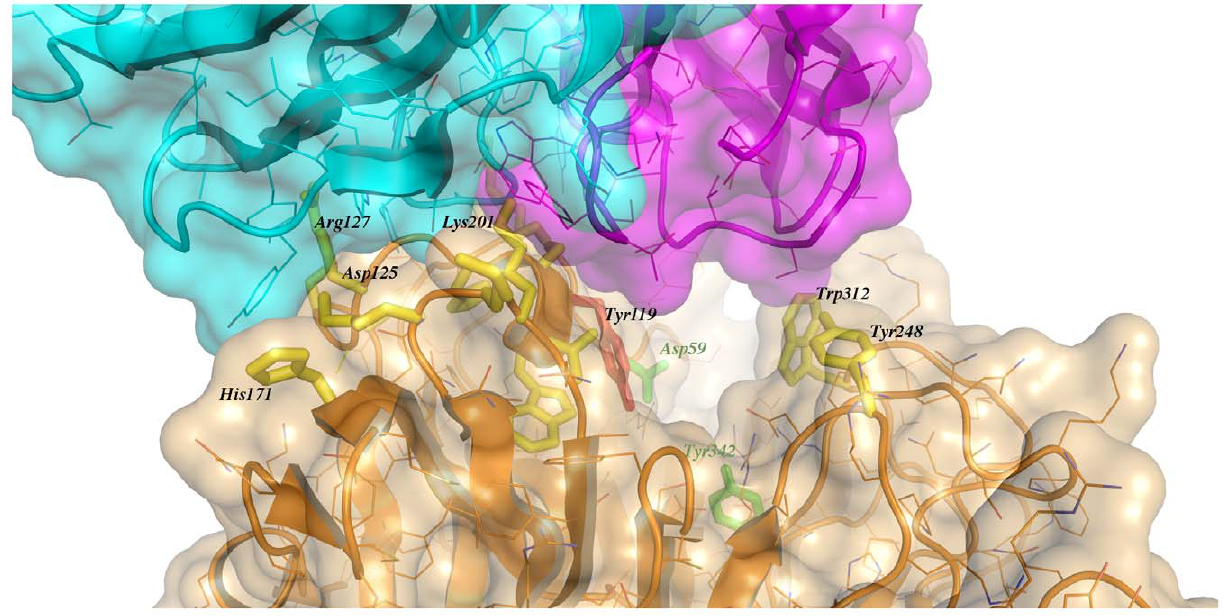
Figure 4. Close-up of the TS/antibody interface. Highlight of the spatial distribution of the epitope residues (in stick representation, colored yellow). TS is shown in orange, light Fab chain in magenta and heavy chain in cyan. For clarity not all the epitope residues are shown nor labeled (see text for full analysis). On top of the cartoon secondary structure representation, residues are represented in lines for the three chains. As a reference for TS positions within the reaction center, the catalytic amino acids Y 342 (on the floor of the pocket) and D 59 are highlighted as green sticks; Y 119 (colored red) forms part of the epitope, normally flexible in free TS. Note how the mAb light chain precludes free mobility of Y 119 , which plays a key function in trans